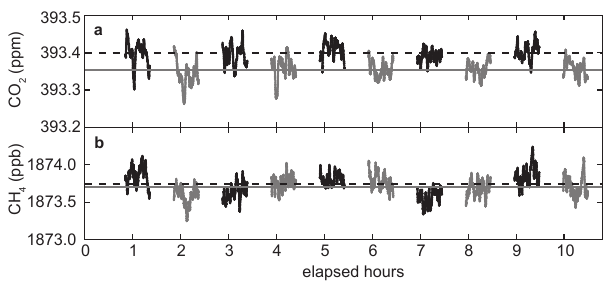
Fig. 3. Wet-air Exp. 1.3 on 2 August 2011. The cryotrap treatment is shown in black and the Nafion treatment is in grey for (a) CO 2 , (b) CH 4 . The first 30min of data were excluded for each treatment. The straight lines are mean values for the cryotrap (black dashed) and Nafion (solid grey) over the entire experiment. The cryotraps plugged up with ice, ending the experiment after approximately 11h. The secondary cryotrap was used in this experiment to remove the water remaining after the Nafion, so no water vapor correction was